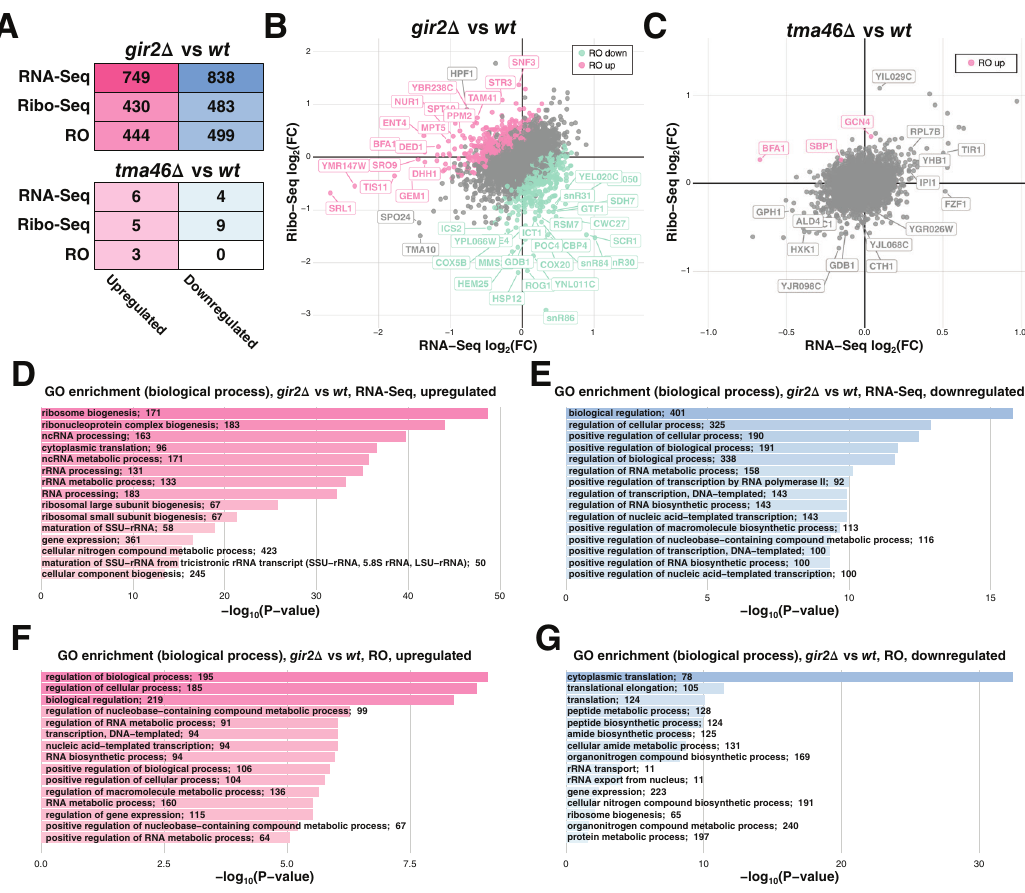
Figure 1. Differential gene expression upon deletions of GIR2 and TMA46. (A) Total number of differentially expressedgenes(passingFDR<0.05)ineachtest.(B)and(C)Scatterplotsillustratingexpressionchangesatthelevel of transcription (X-axis, RNA-Seq) and translation (Y-Axis, Ribo-Seq) in the gir2 Δ and tma46 Δ strains, respectively. Translationally upregulated or downregulated (FDR < 0.05) genes marked in pink/blue, respectively. (D-G) Results of Gene Ontology (GO) enrichment analysis of RNA-Seq (D-E) and ribosome occupancy (RO) (F-G) considering upregu- lated(D,F)anddownregulated(E,G)genesin gir2 Δ vs. wt comparison.Thenumbersofdifferentiallyexpressedgenes with particular GO terms are shown in labels. X-axes show the enrichment P-value in